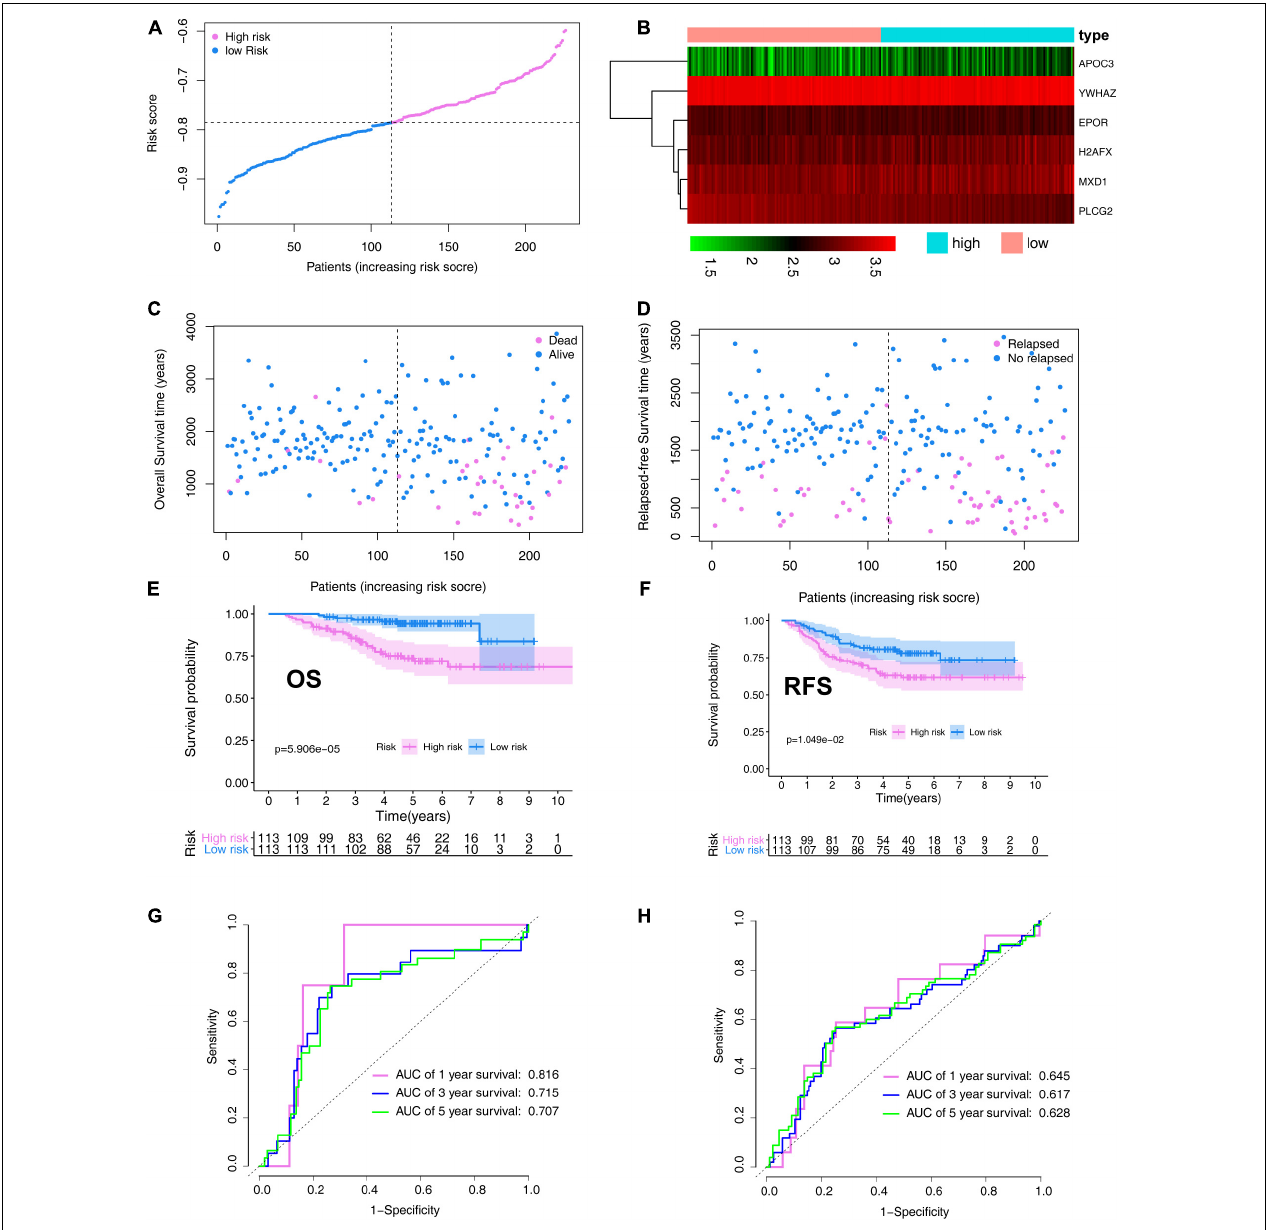
FIGURE 6 | Verification the prognostic value of the ARG signature in the validation set (GSE31210). (A) Distribution of the risk scores calculated by the risk score. (B) Heatmap of the ARG expression profiles based on the RNA-seq data. (C) Patient distribution in the low- and high-risk score groups based on overall survival status. (D) Patient distribution in the low- and high-risk score groups based on relapse-free survival status. (E) Overall survival curves stratified by the low- and high-risk group. (F) Relapse-free survival curves stratified by the low- and high-risk group. (G) Time-dependent ROC curves for ARG-based overall survival prediction. (H) Time-dependent ROC curves for ARG-based relapse-free survival